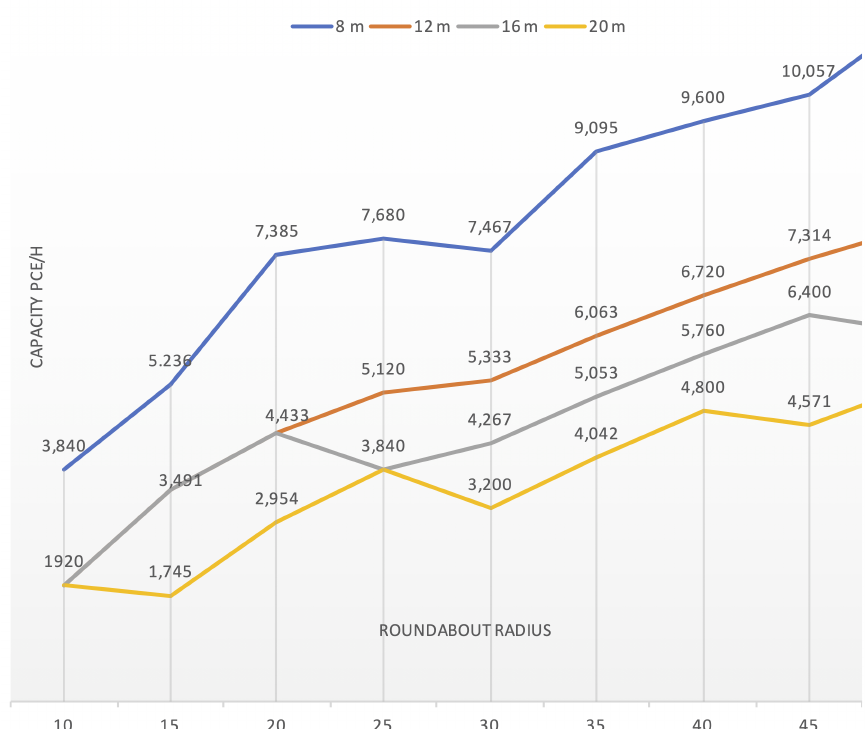
Figure 13. Maximum roundabout capacities vs. vehicle distances and roundabout radius.